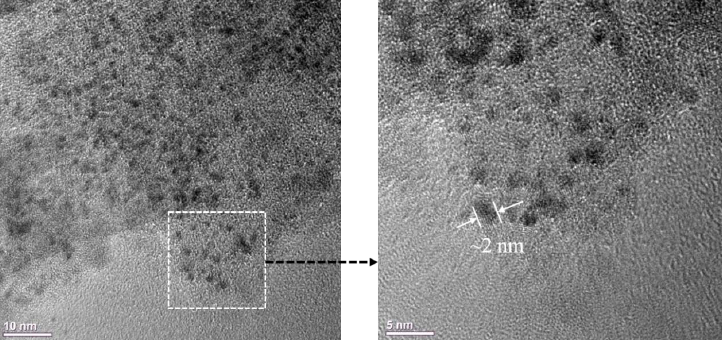
Figure 4. TEM images of M@S with different magnifications.